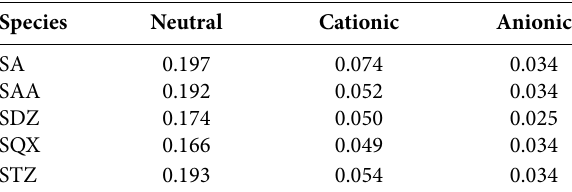
Table 4. Calculated values for HOMO-LUMO gaps (eV) for studied species in neutral and ionic states. Species Neutral Cationic